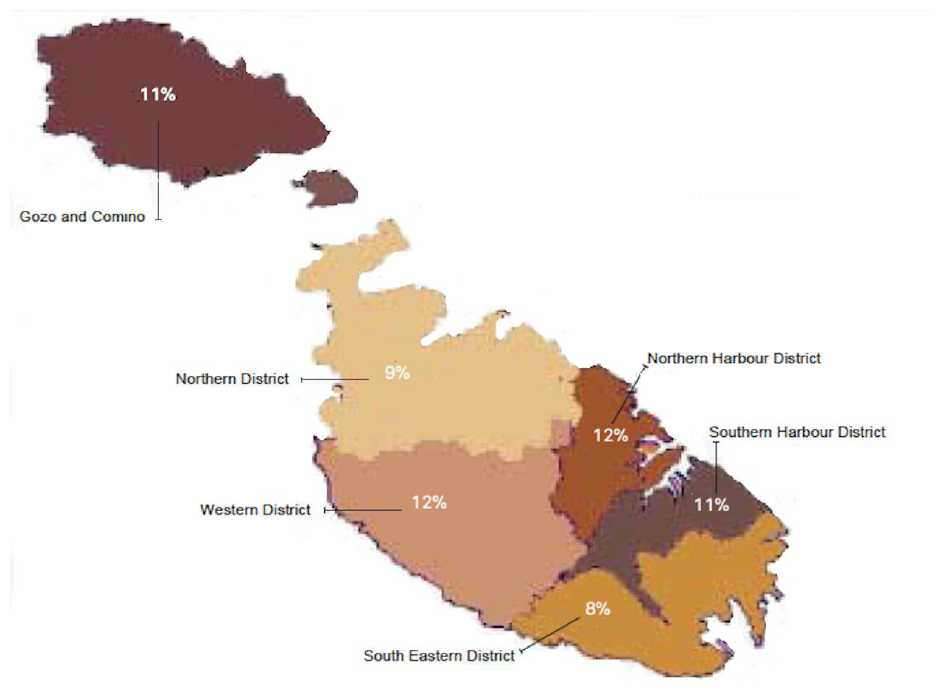
Figure 3. Global diabetes prevalence levels by district in Malta 2014 –